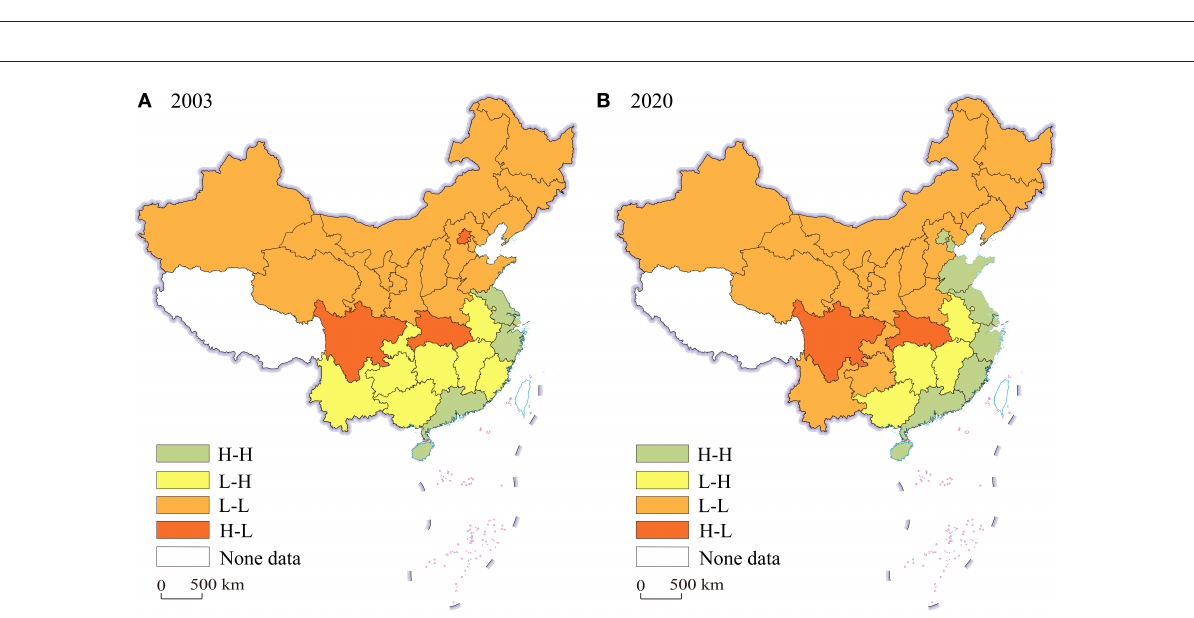
FIGURE3 LISA agglomeration maps of TCEE. (A) 2003; (B)